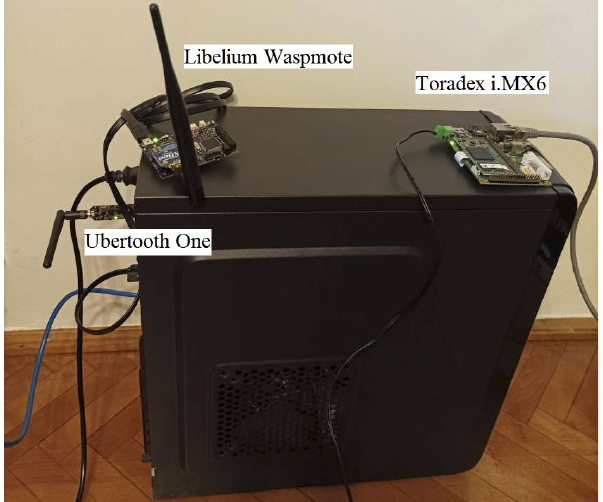
Figure 6. Hardware components used in creating the SDN hybrid software and hardware simula- tion